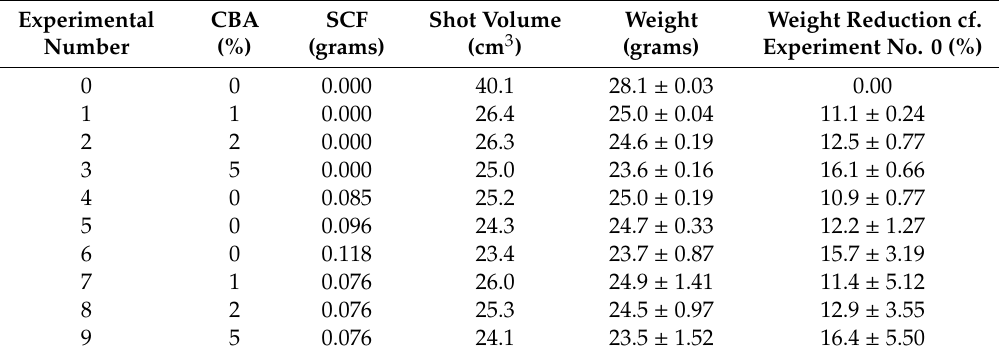
Table 2. Input processing data used for talc-filled PP.